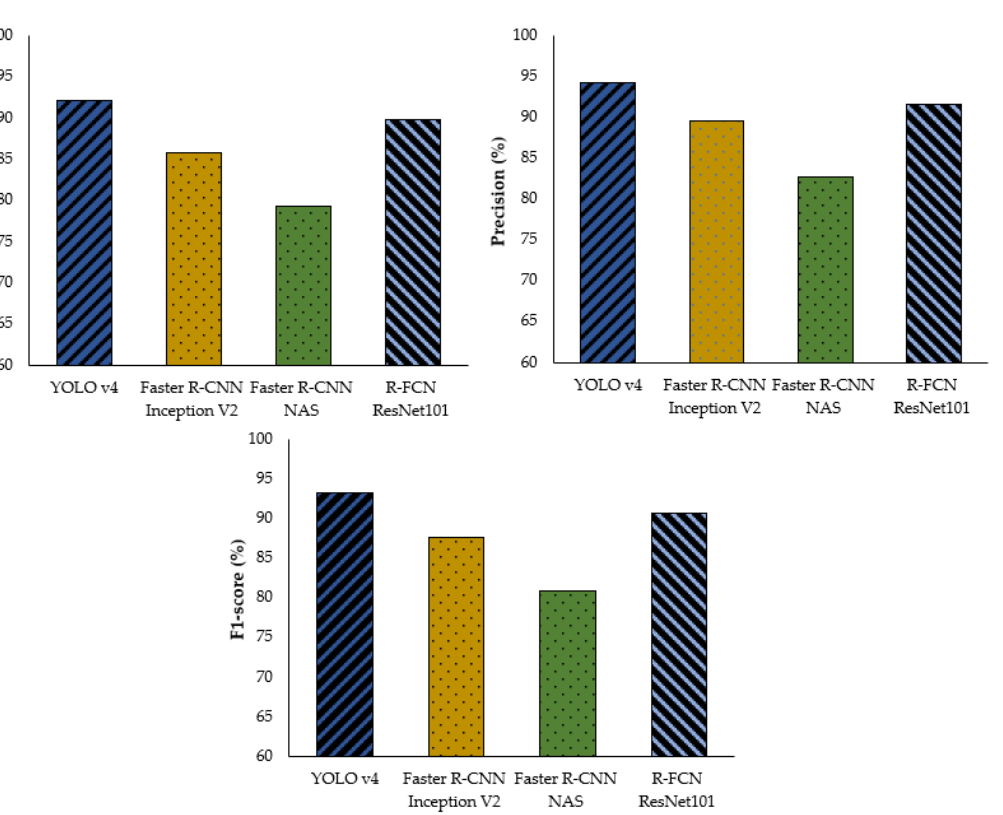
Figure 7. Precision, recall and F1-score for the developed CNN models. Examples of detected damage by YOLO v4, R-FCN ResNet101, Faster R-CNN Incep- Examples of detected damage by YOLO v4, R-FCN ResNet101, Faster R-CNN